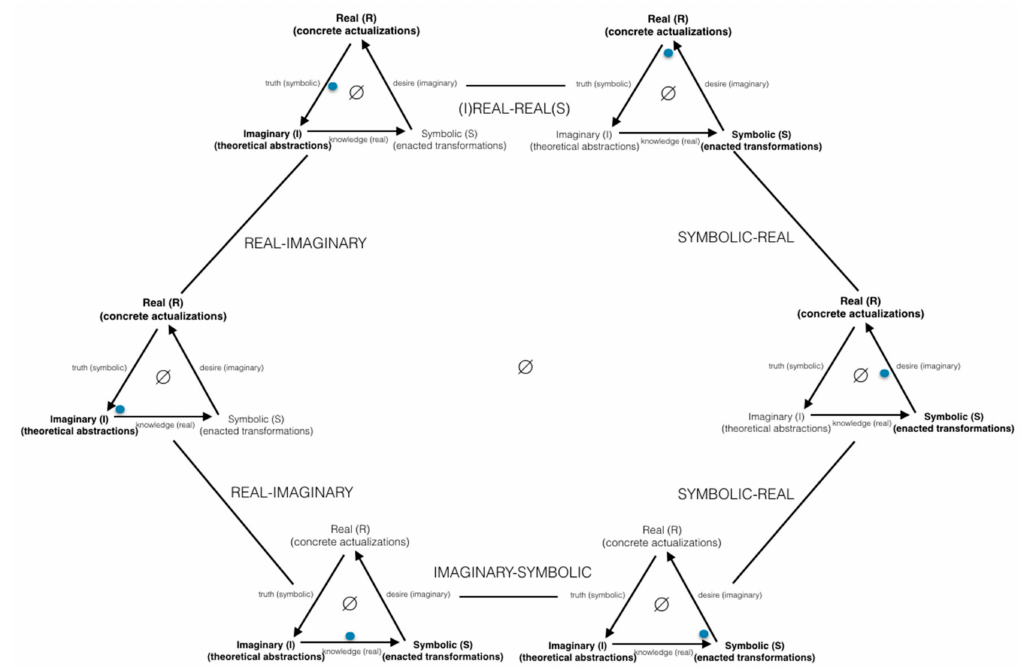
Figure 8. Structural transformations on the transcendental horizon: cyclohedron. The geometry of the triad is a classical structure of logic used to study the nature of the human mind (e.g., for psychoanalysis: [85]; and philosophy: [86]; see also: [87]). However, in order to capture a larger view of totality in triadic transformation we must also represent the dynamical motion with a higher dimensional cyclohedron representing the circular-orbital temporality of desire (blue dot, objet a) as it passes from imaginary-symbolic, symbolic-real, and real-imaginary. Cyclohedrons complexify triads in geometrical analyses used to study knot invariants ([88,89]). Here knot invariants are desire deadlocks (points of impossibility) fundamental to understanding the structure of pure desire. In this frame ‘knots’ can be located on the level of the symbolic transformation which generates a perceived subjective separation/connection (in space) and distance/closeness (in time) from the ‘real event’ as the ‘desired state’ (ideal-real). In other words, when symbolic transformations ‘miss’ on returning from the real there is a subjective emptiness (filled only with the real of imaginary potentiality), and when symbolic transformations ‘hit’ on return from the real there is a subjective fullness (where the imaginary intersects with the real actuality of desire).